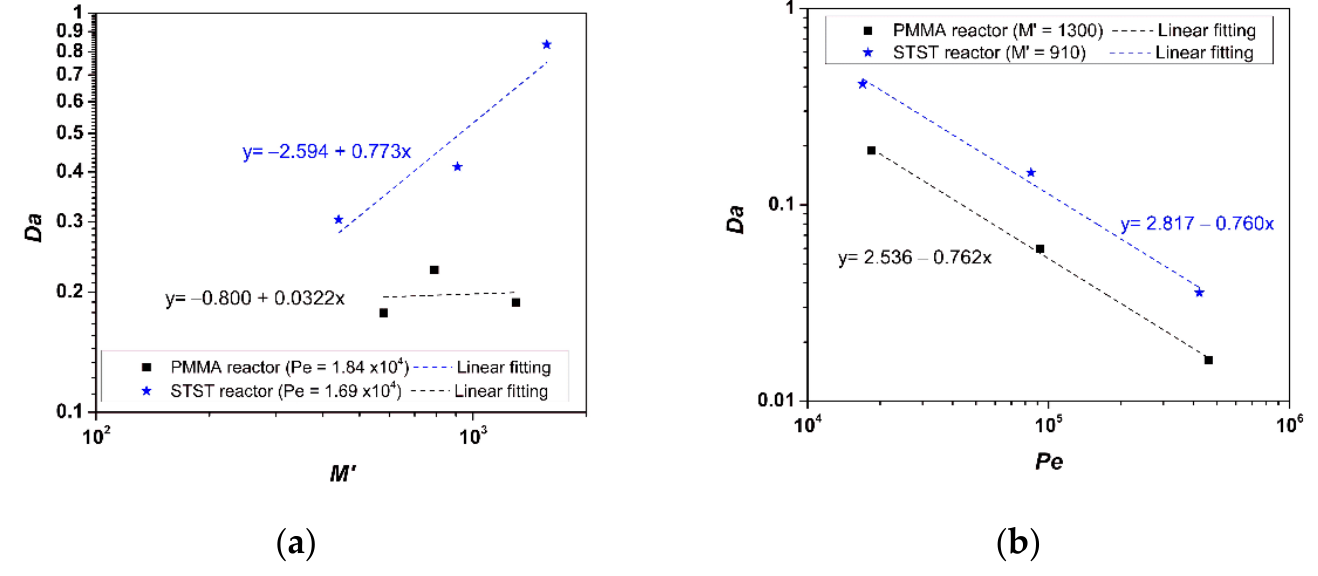
Figure 13. Dependence of Damköhler number on ( a ) the ratio of catalyst mass to the initial mass of pollutant and ( b ) the Peclet number.